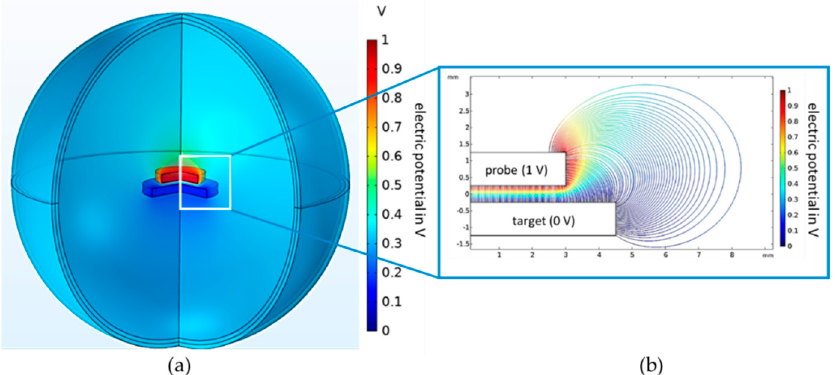
Figure 2. FEM simulation result of the parallel plate capacitor. ( a ) Electric potential distribution of the complete model. The probe has an electric potential of 1 V and the target of 0 V. The surroundings are an air sphere with infinite boundary conditions. ( b ) Propagation of the electric field lines. There are fringe fields at the edges of the electrodes.